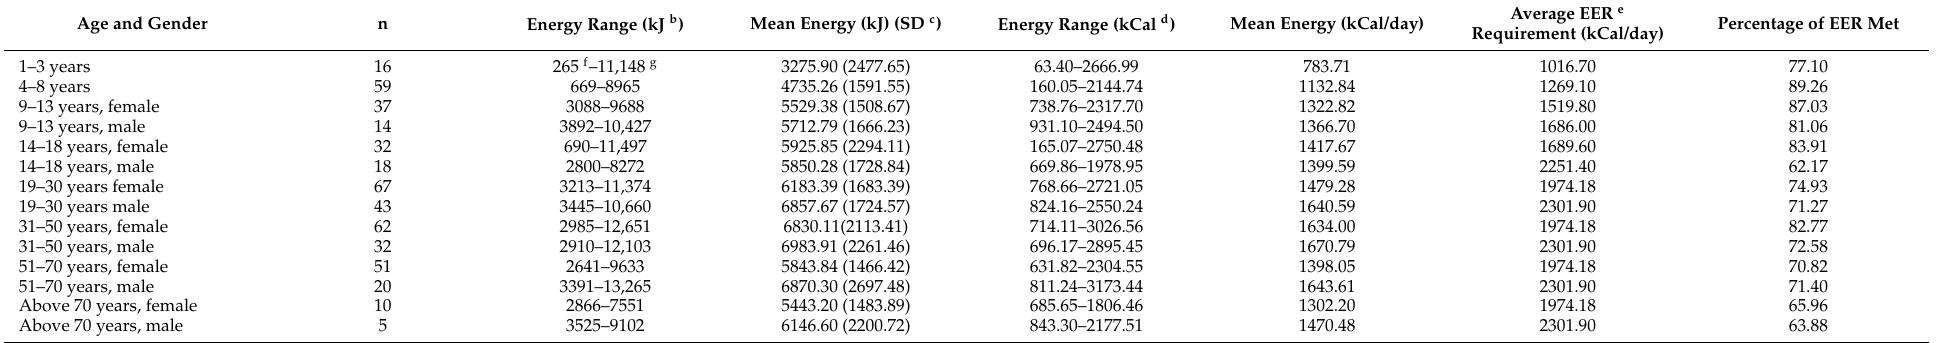
Table 8. Comparison of mean energy intake with the EER a from two 24 h repeated recalls for individuals aged ≥ 1– ≥ 18